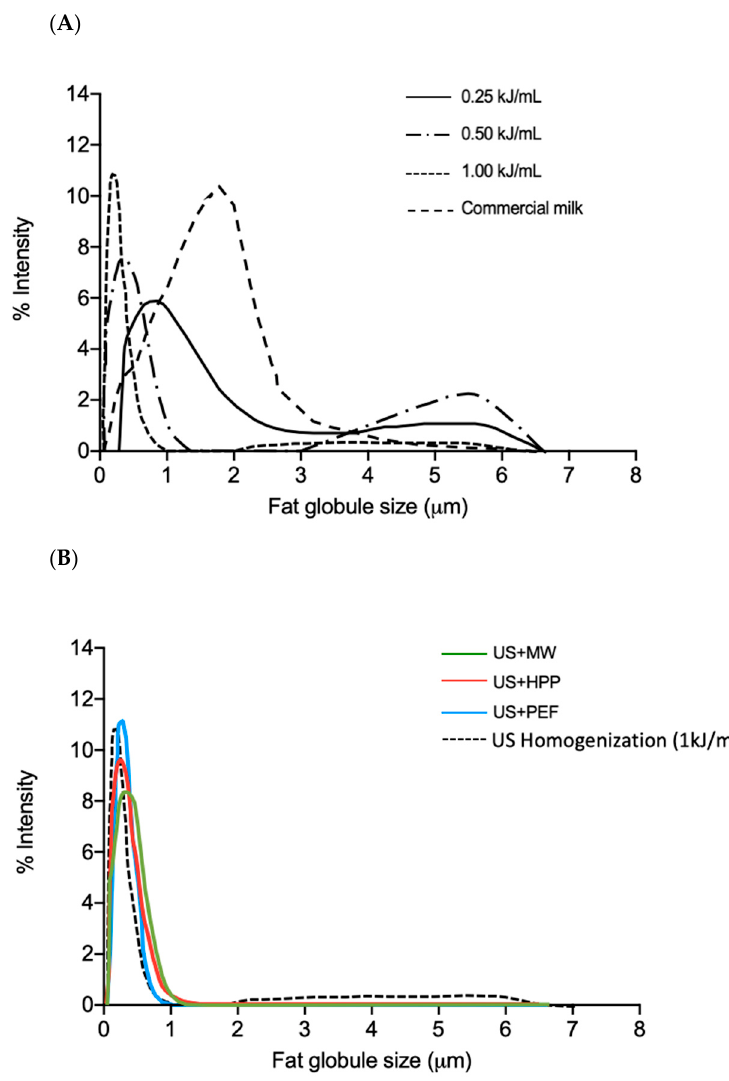
Figure 3. Size distribution of milk fat globules: ( A ) after US homogenization at different energies; ( B ) after US homogenization at 1 kJ/mL (US), followed by MW (US + MW), HPP (US + HPP), and PEF (US + PEF) pasteurization.